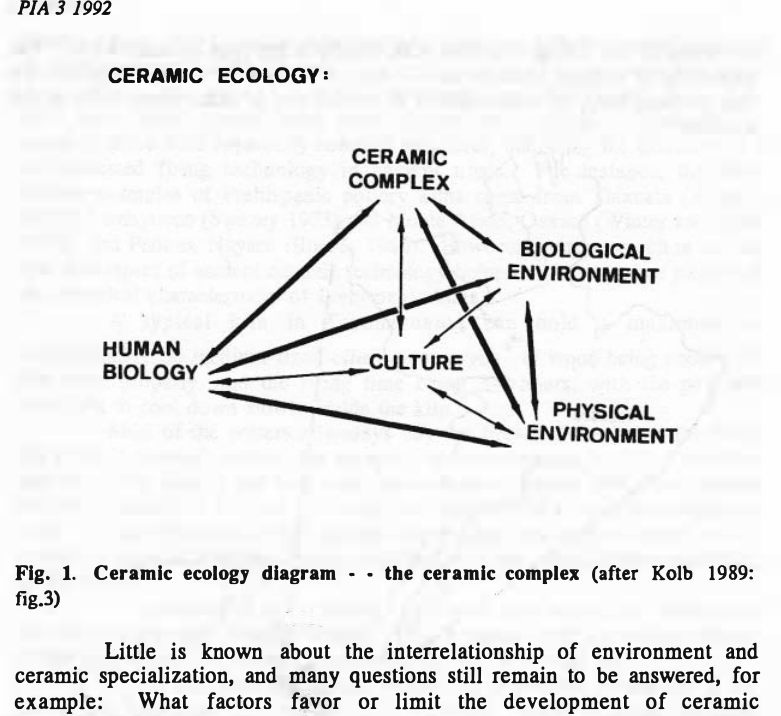
1. Ceramic ecology diagram • • the ceramic complex (after Kolb 1989: